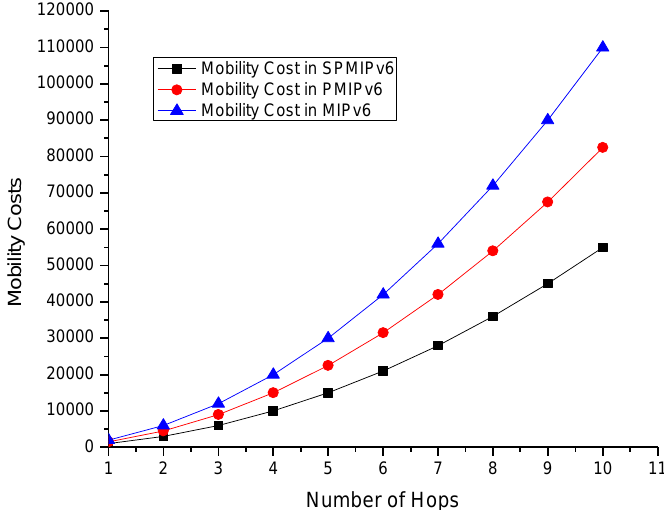
Figure 12. Number of Hops vs. Mobility Cost.